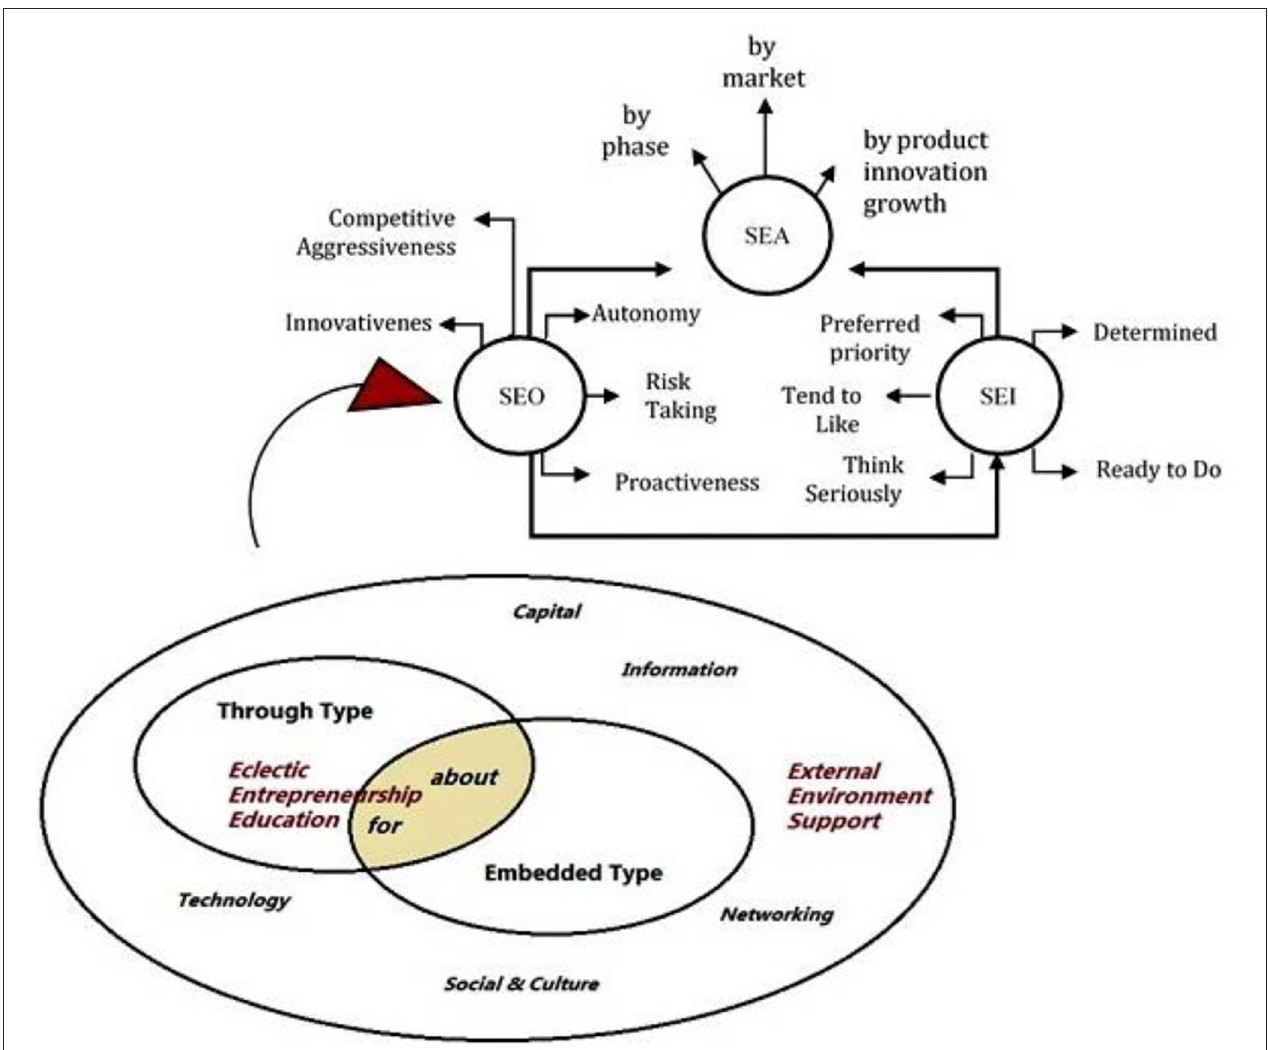
FIGURE 4 | Empirical model of Indonesian University entrepreneurship